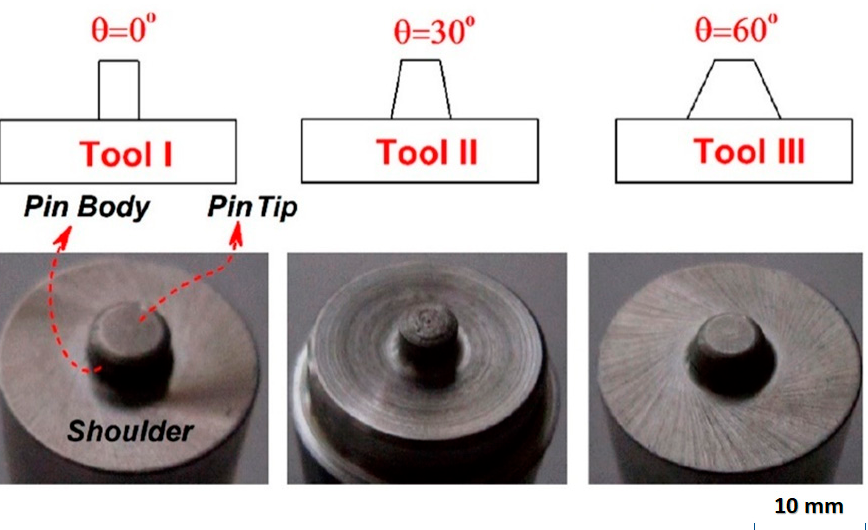
Figure 13. Schematic view and image of used tapered ( center and right ) and straight cylindrical ( left ) tools in this study [136]. Reprinted under the CC BY 4.0 License.